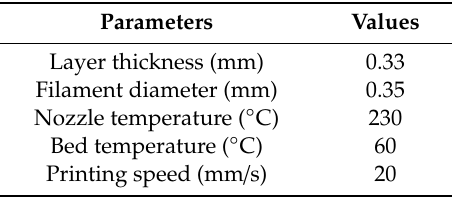
Table 1. Sca ff old printing